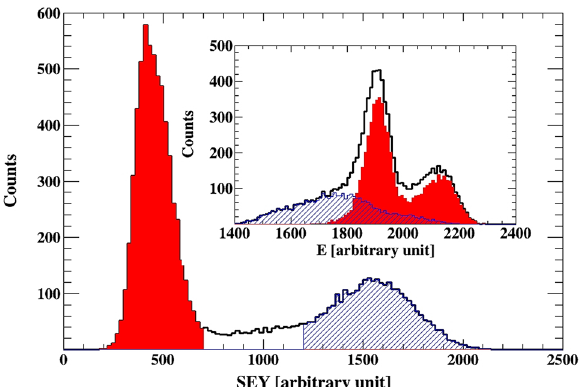
Figure 3. The SEY measured for the ZnO/GaN, where the inset shows the corresponding spectrum obtained from the Si detector. Gates are placed on the SEY data, the corresponding events in the Si detector are shown in the inset. The result demonstrates the relation between higher SEY yield and lower energy in the Si detector, and lower SEY yield and higher energy deposited by the Au ions in the silicon detector. The higher SEY yield is related to Au ions passing through the nanotube, while the lower yield is observed for ions passing in the lulls/ drops between the nanotubes.